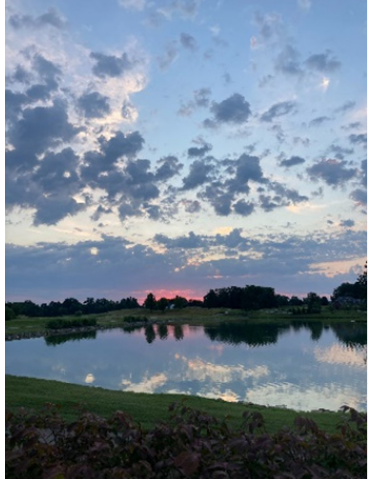
Figure 6. A pond. Figure 6. A pond.